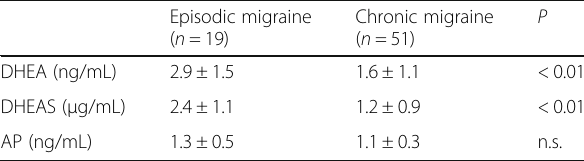
Table 6 Plasma neurosteroid levels in patients affected by cluster headache and their healthy